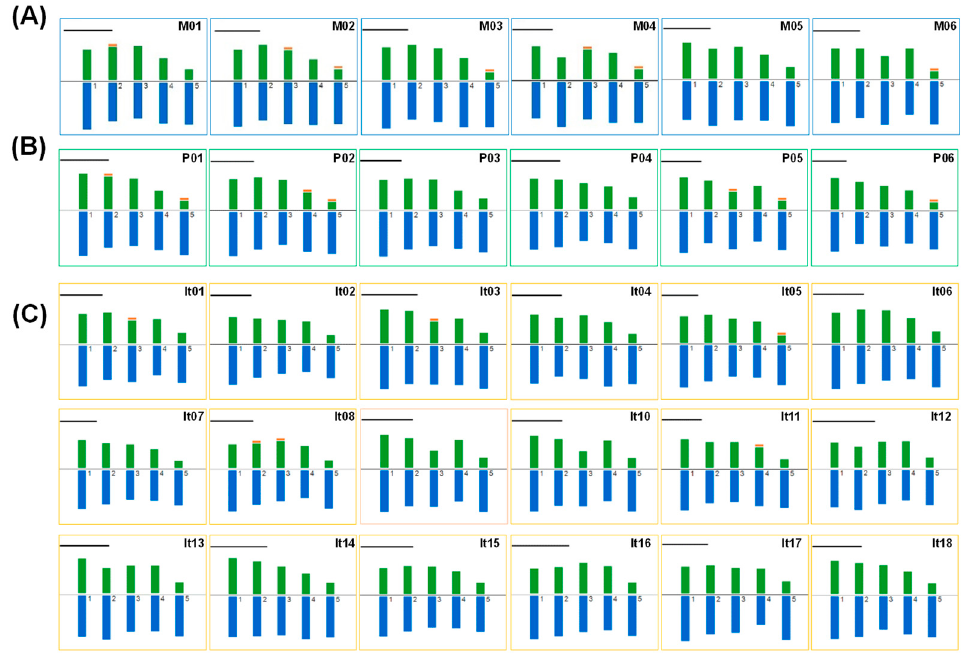
Figure 3. Chromosome idiograms of 30 species or varieties in Paeonia L. of ( A ) sect. Moutan , ( B ) sect. Paeonia , and ( C ) Itoh hybrids. The orange fragment on the top of partial chromosomes indicates satellites. The names of each code on the upper right of each image are shown in Tables 1 and 2; bar = 10 μ m.